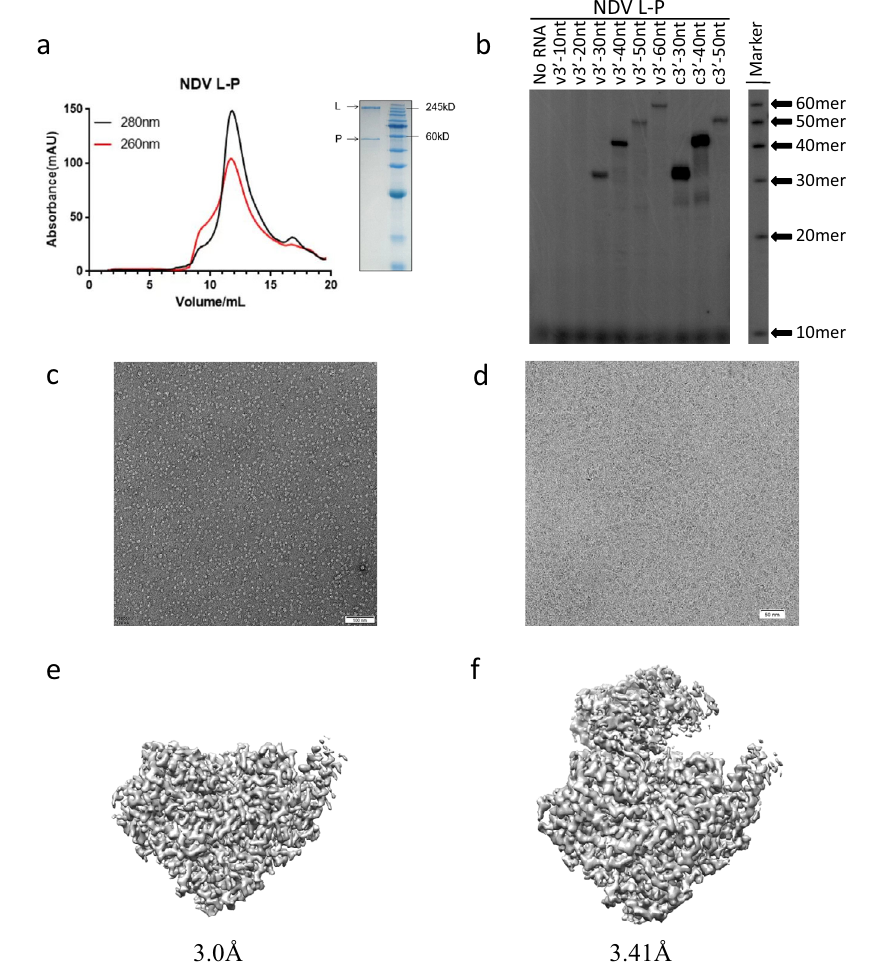
Fig. 1 | Biochemical characterization and cryo-EM structure of NDV L-P com- plex. a Elution pro fi le of the puri fi ed NDV L-P complex on a Superose 6 Increase size-exclusion column. SDS-PAGE was performed to assess the quality of L-P complex. b Shown the RNA products generated from RNA synthesis reactions. c A representative negative staining micrograph of NDV L-P complex. d A